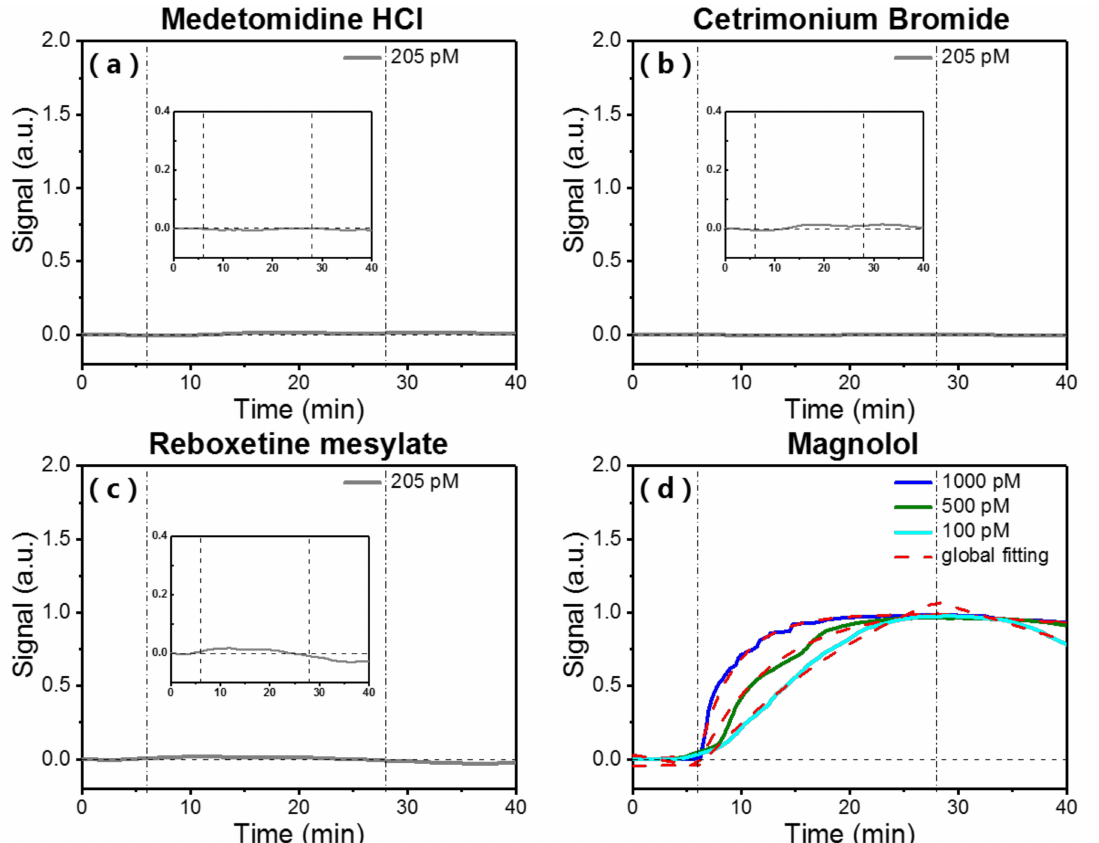
Figure 5. Real-time binding curves of small molecules ( a ) medetomidine HCl; ( b ) cetrimonium bromide; ( c ) reboxetine mesylate with surface-immobilized streptavidin on packaged OFMBR sensor at respective concentration of 205 pM (Insets show enlarged views of the binding curves); ( d ) Binding curves of surface-immobilized streptavidin with flowing magnolol at concentrations of 100 pM, 500 pM, and 1000 pM. Vertical lines are the starts of association and dissociation